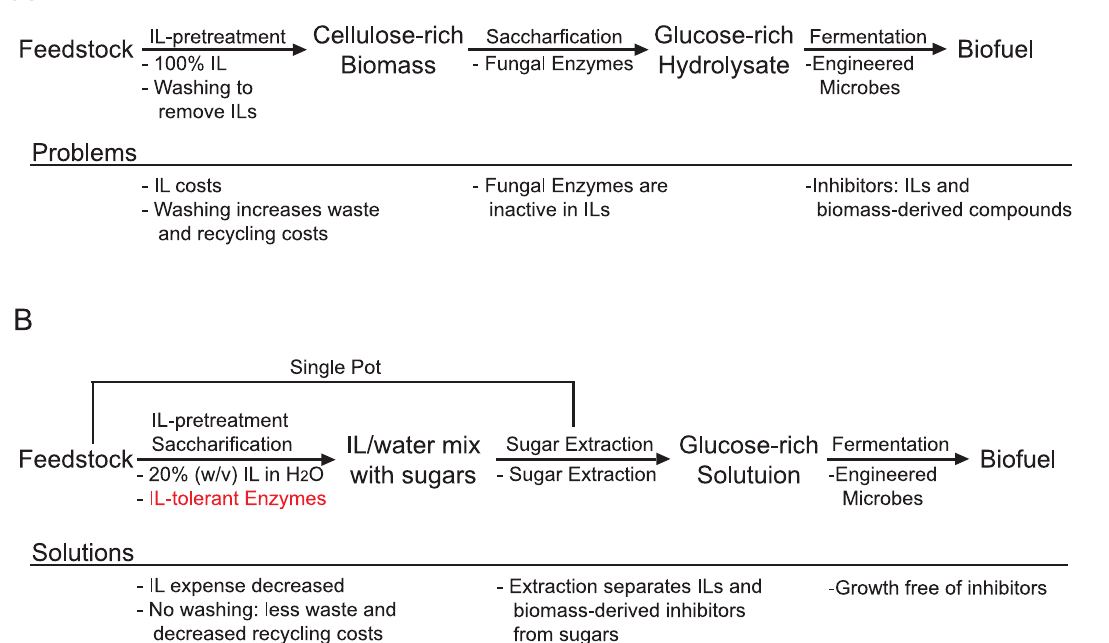
Figure 1. A flow diagram of two potential biomass-to-biofuel bioprocessing configurations that utilize IL-pretreatment. A) Diagrams a configuration based on methods currently established in the literature and lists some potential barriers to commercialization (Problems). B) This configuration combines IL-pretreatment and saccharification into a single pot and may overcome barriers outlined in A (as listed in the solutions section), but requires an IL-tolerant cellulase cocktail, such as JTherm.